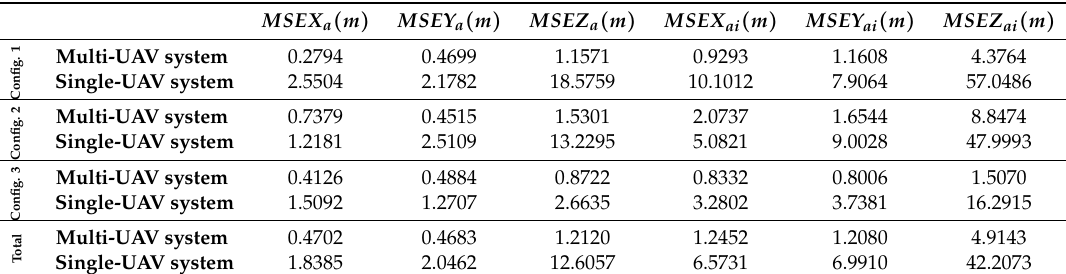
Table 5. Total Mean Squared Error in the position estimation of the landmarks ( MSEX a , MSEY a , MSEZ a ). Total Mean Squared Error in the initial position estimation of the landmarks ( MSEX ai , MSEY ai , MSEZ ai